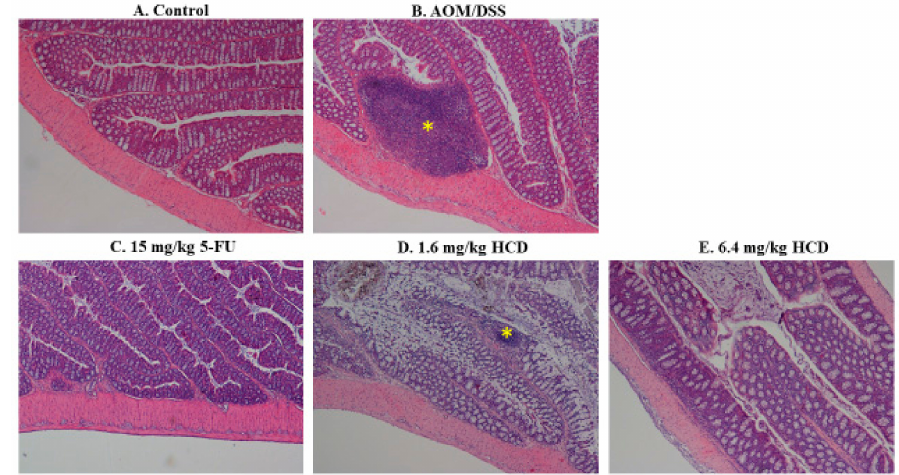
Figure 2. Histological changes of intestinal lymph nodes in HCD-treated mice with inflammatory bowel disease (IBD). The intestinal lymph nodes of ( A ) the control, ( B ) mice with AOM / DSS induction, and mice with AOM / DSS induction followed by ( C ) 15 mg / kg B.wt of 5-FU, ( D ) 1.6 mg / kg B.wt, and ( E ) 6.4 mg / kg B.wt of HCD treatment ( n = 5 in each group) were stained and photographed. The yellow asterisk indicates the lymph node in the intestine. Magnification = ×